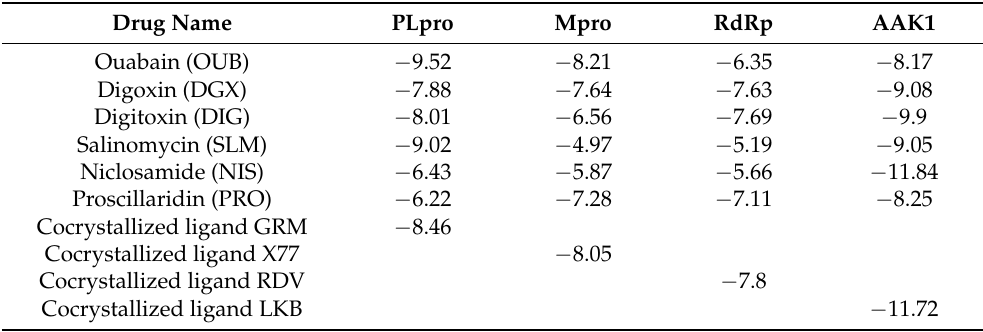
Table 2. Affinity energy (AE) values (Kcal/mol) of binding for FDA-approved repositioned drugs to selected SARS-CoV-2 target